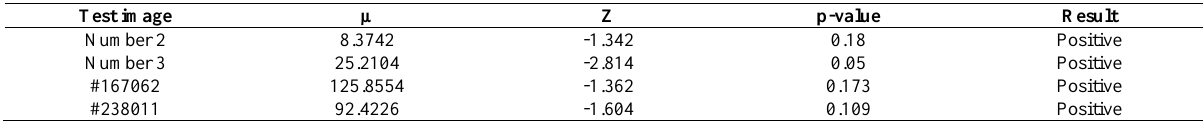
Table 6. Results of the Wilcoxon